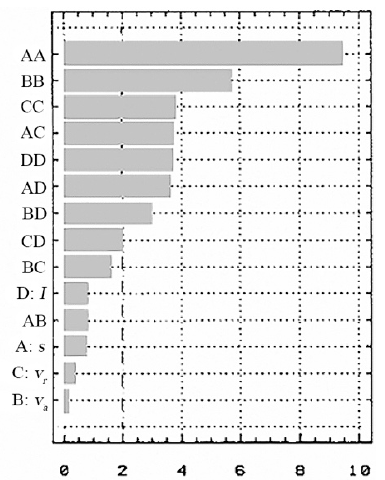
Figure 14. The input factors influence on t t [s].